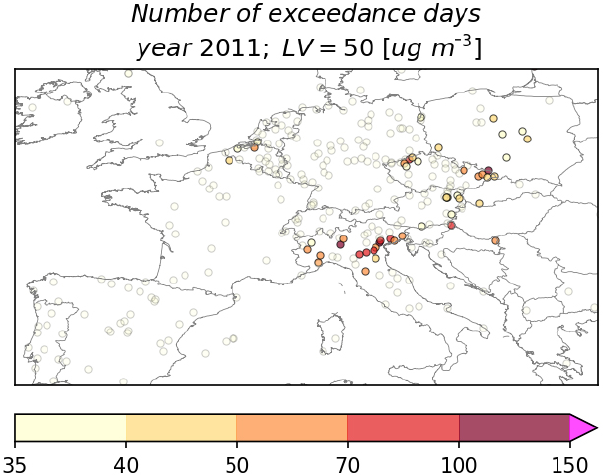
Figure 1. Number of days exceeding the daily limit PM 10 value (LV) at rural background stations during the year 2011 in the do- main of the research. Stations marked with a grey circle repre- sent less than or equal to 35 permitted exceedances during the year (2008/50/EC